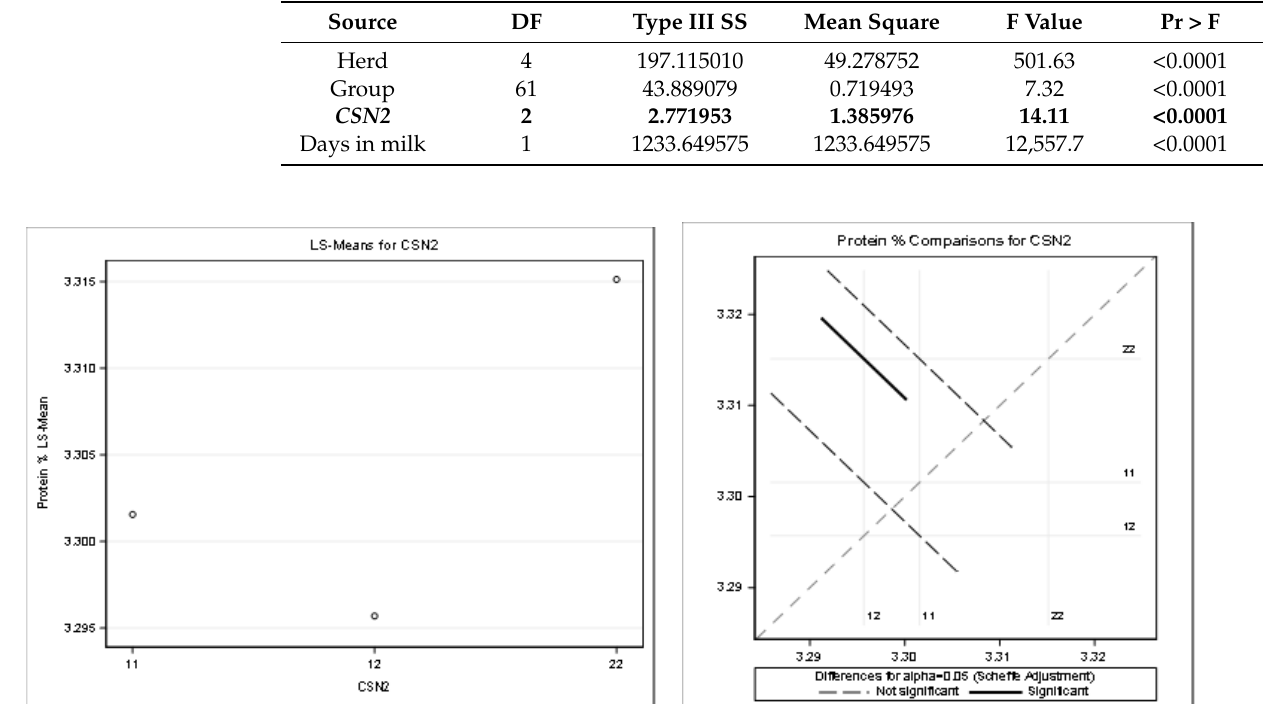
Figure 7. Least squares means and multiple comparisons for protein kg.